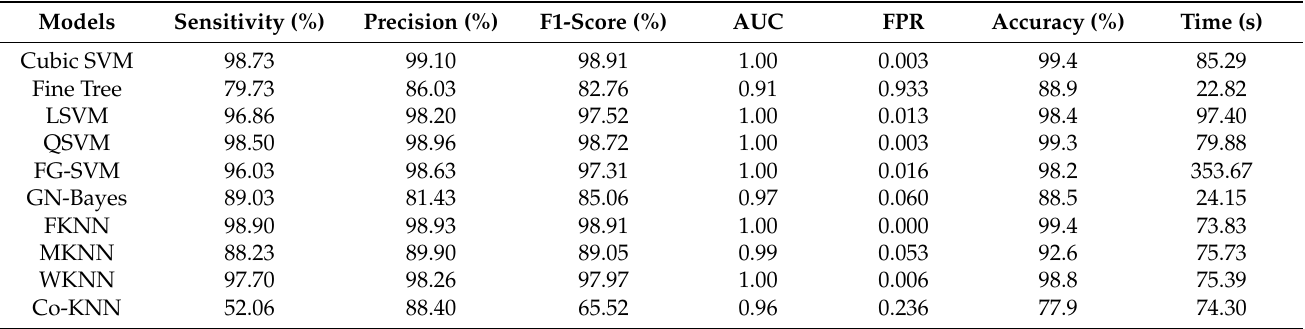
Figure 13. Time comparison with individual machine learning classifiers of deep learning models for CBIS-DDSM. Table 8. Classification results using Fine-tuned MobilenetV2 deep features for